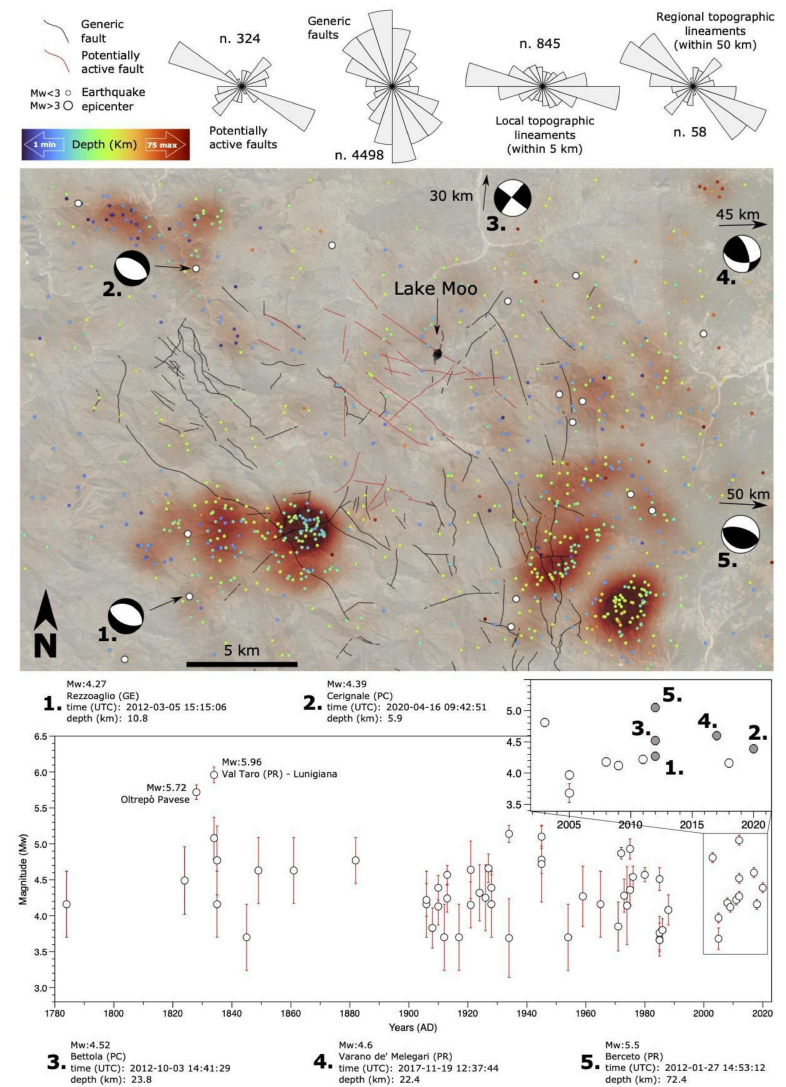
Figure 12. Heatmap overlay of earthquake epicenters, color coded by depth (time interval 1541–2021; [24]), on Google Earth satellite imagery of the area surrounding the Lake Moo basin, with rose diagrams summarizing the main structural orientations. Generic fault and potentially active fault data from [1] and [23], respectively. In the bottom diagram, chronological distribution of historical M > 3 seismic events occurred in an area of 50 km radius around Lake Moo. Data from [24]. The main M > 4 earthquakes with available reconstructed focal mechanisms are